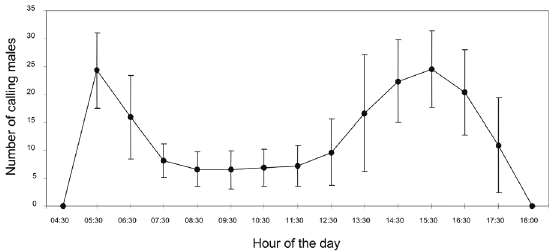
Figure 2 - Daily cycle of calling activity of Allobates subfolionidificans in Rio Branco, western Amazonia. Dots represent the mean number of calling males recorded in each interval at the study site, and vertical bars correspond to the standard deviation.